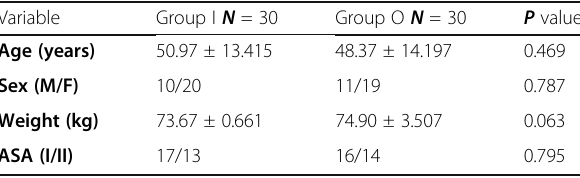
Table 1 Patients ’ demographic data